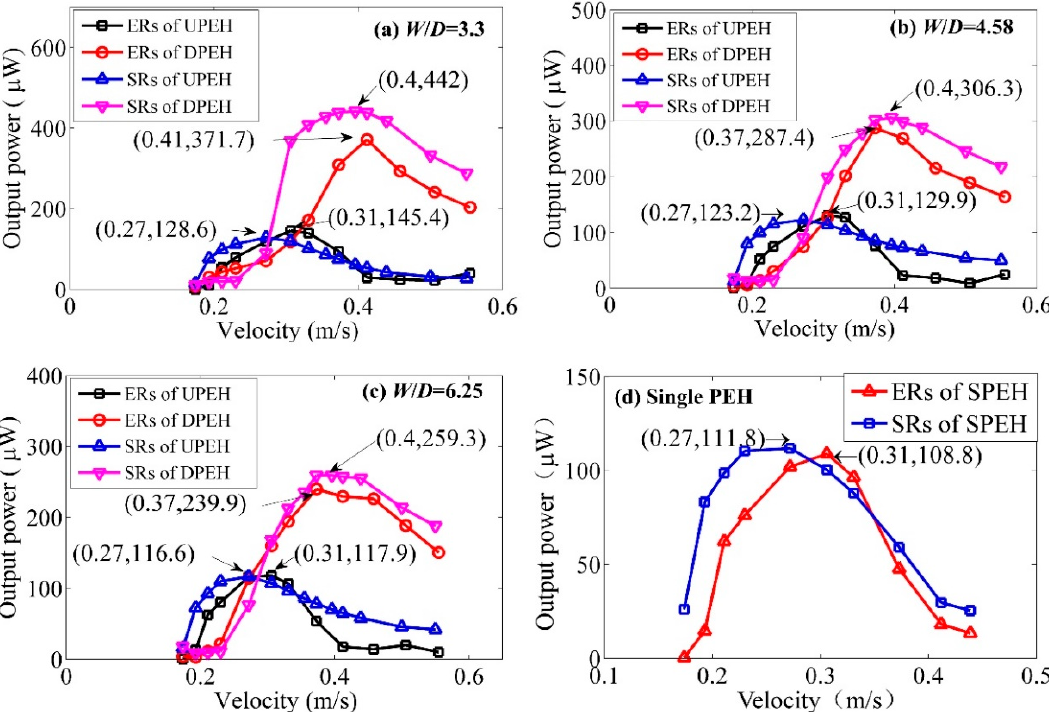
Figure 6. Output power of simulation results (SRs) and experimental results (ERs) of two tandem PEHs ( a – c ) and single PEH ( d ).